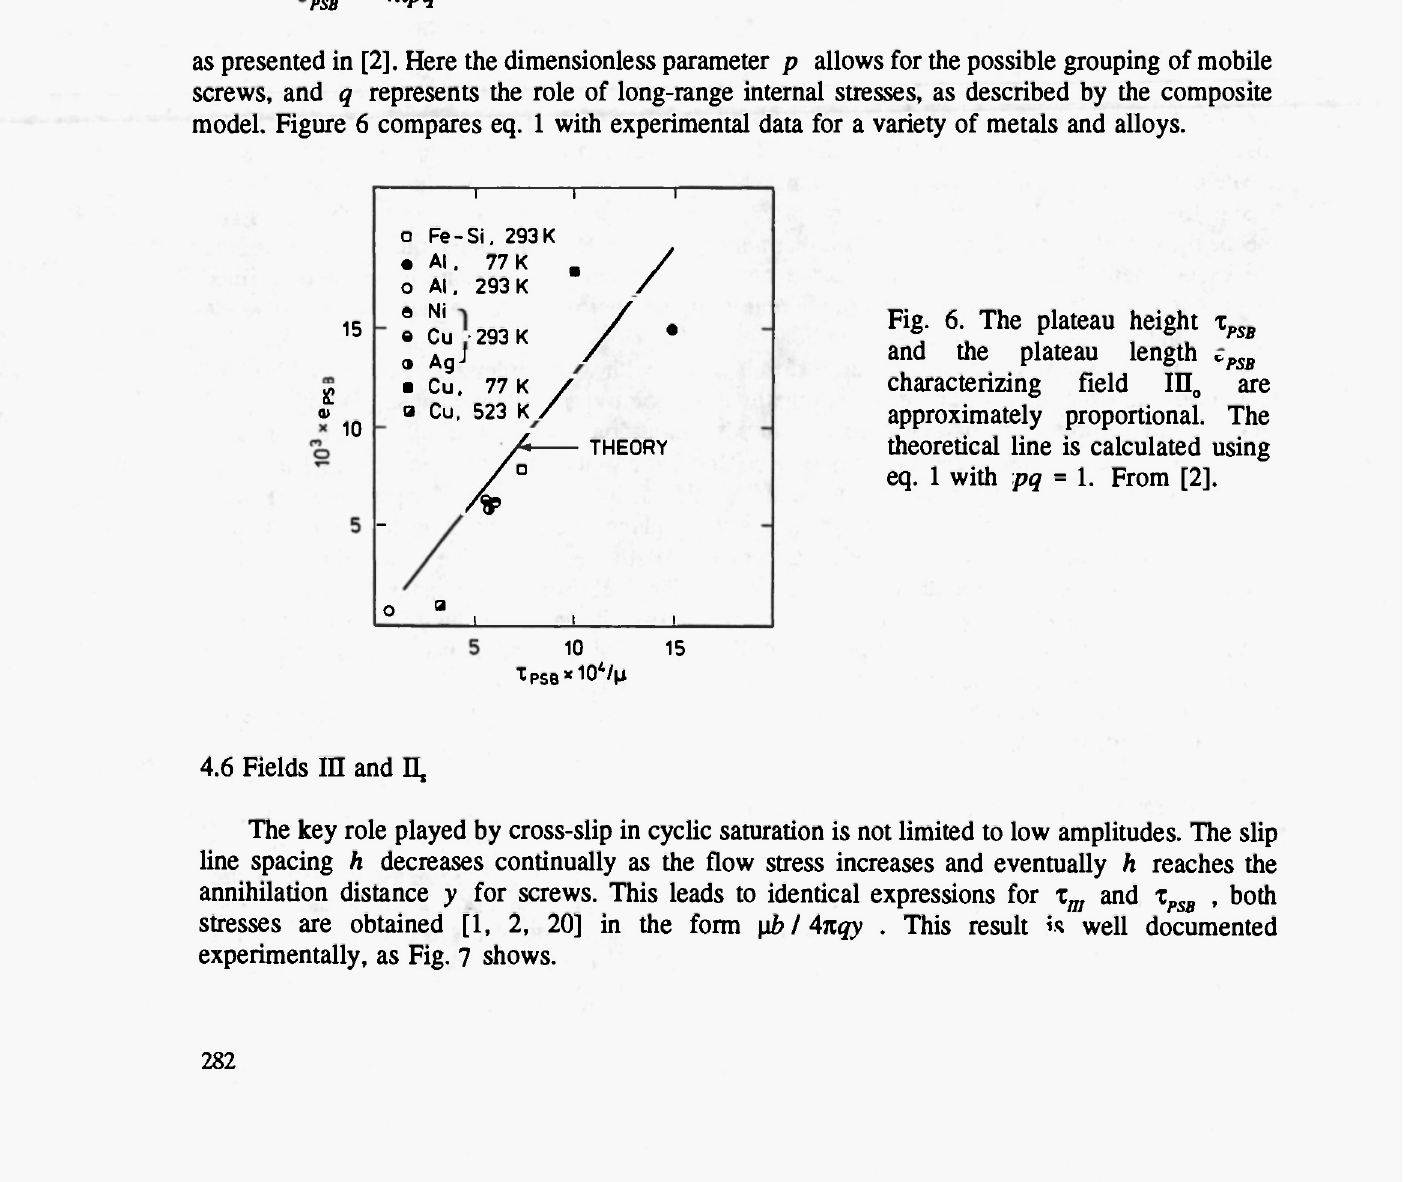
Fig. 6. The plateau height τ and the plateau length * characterizing field ΙΠ approximately proportional. The theoretical line is calculated using eq. 1 with pq = 1. From